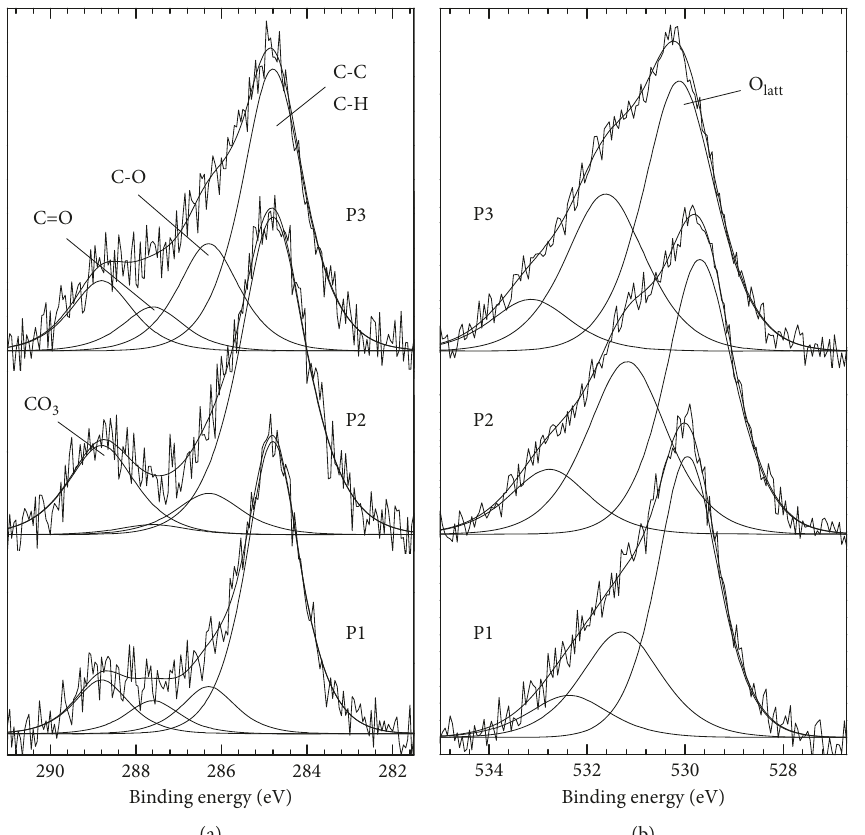
Figure 3: XPS photoelectron spectra of (a) C 1s and (b) O 1s in Mn-Zn ferrite: P1-C2O4, P2-CO3, and